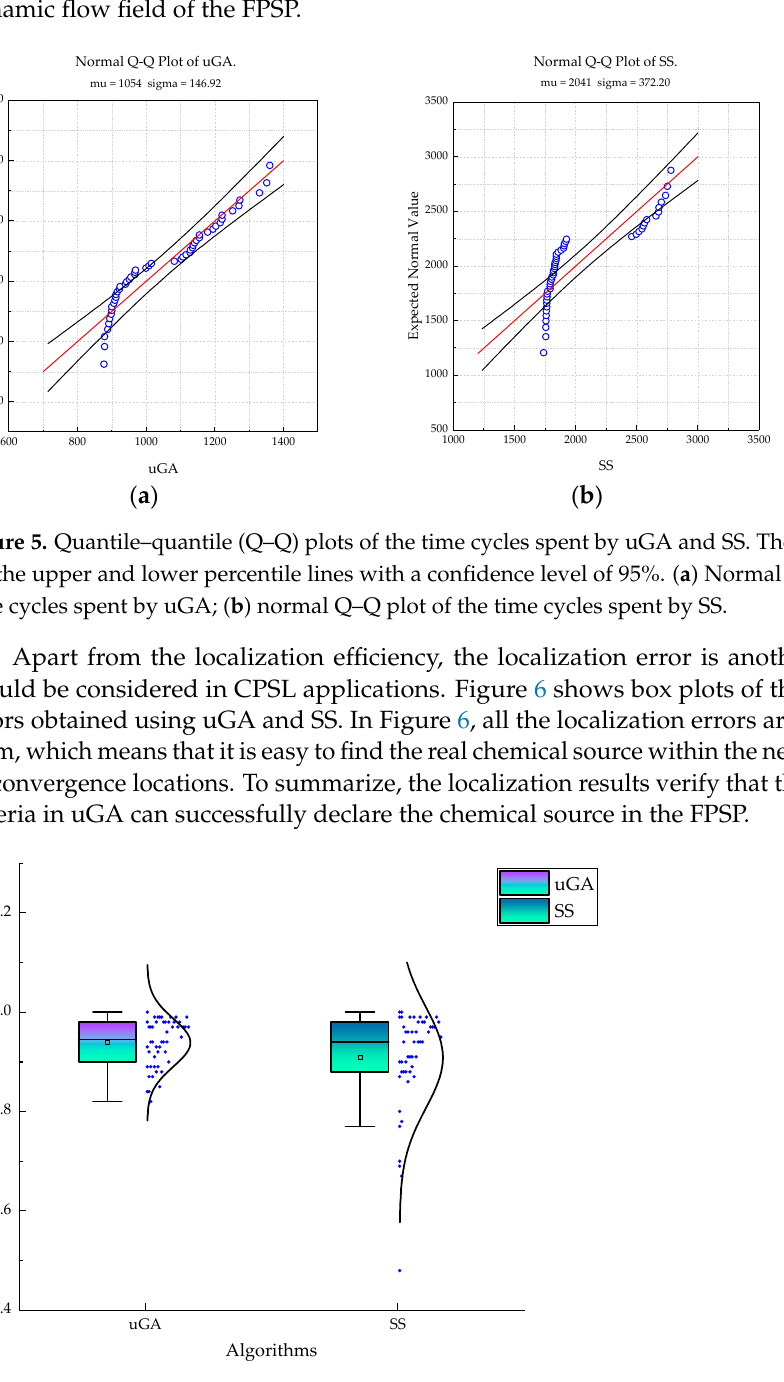
Figure 6. Box plots of the localization errors obtained by the uGA and SS methods. Each box plot is based on the results of 50 trials.